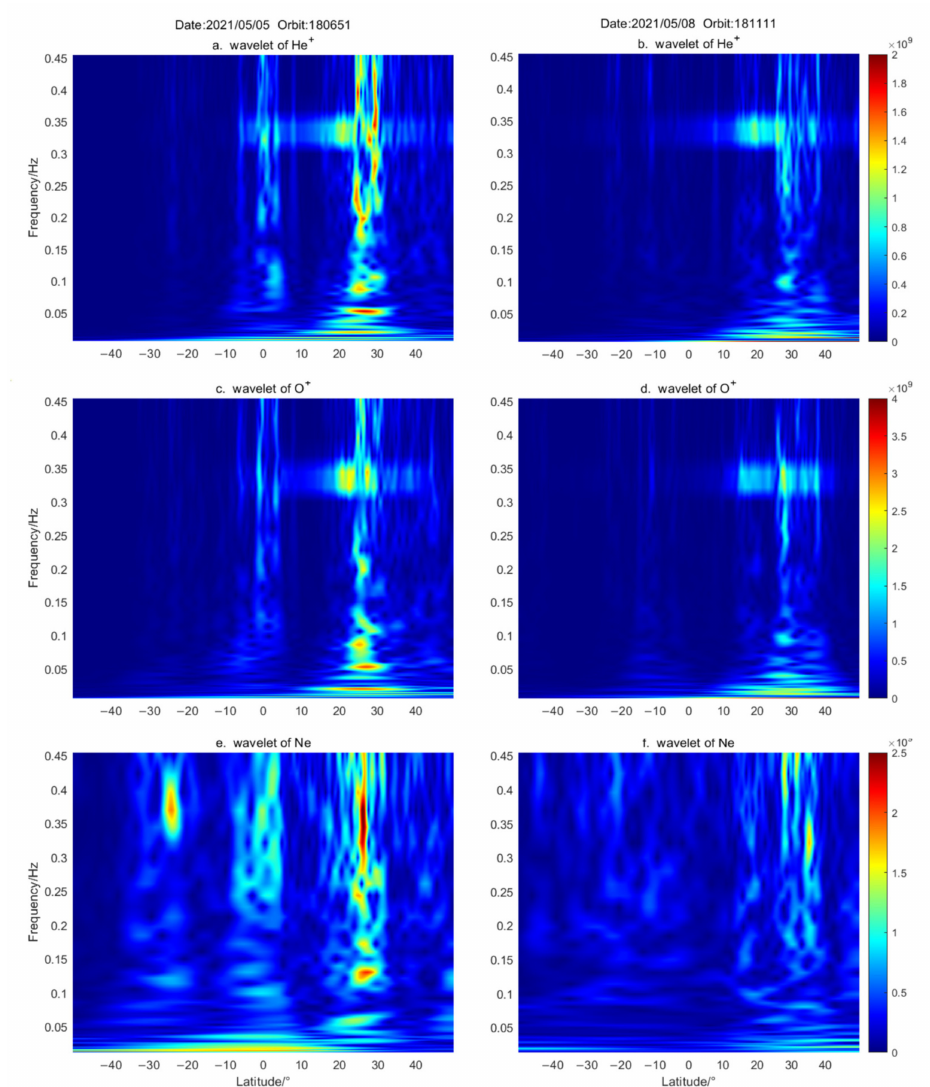
Figure 10. Wavelet transform of abnormal signals. ( a , c , e ) represent the wavelet transform results of He + , O + , and Ne on 5 May, respectively. ( b , d , f ) are 8 May. Results for the same orbit are distributed in columns, and results for the same parameter are distributed in